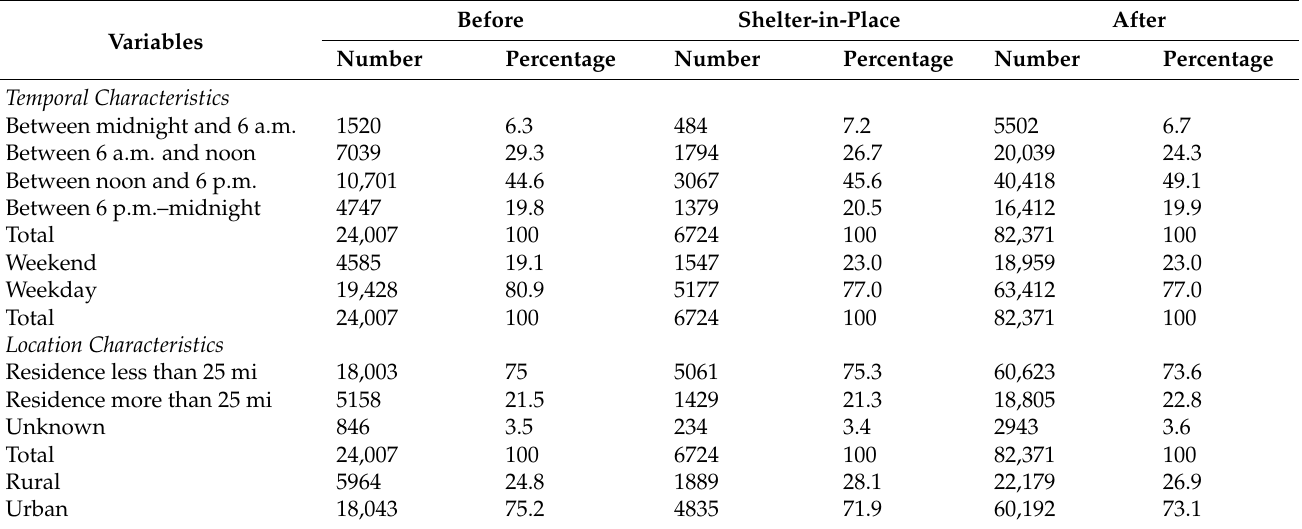
Table 2. Descriptive statistics of variables available for model